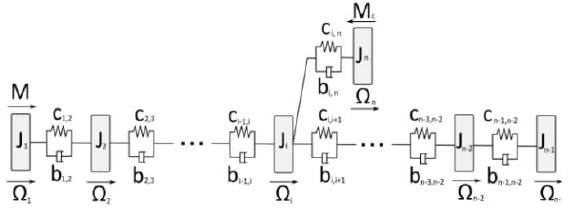
Fig. 7. Block diagrams of discrete chain systems: a) with free motor rotor; b) with fixed motor